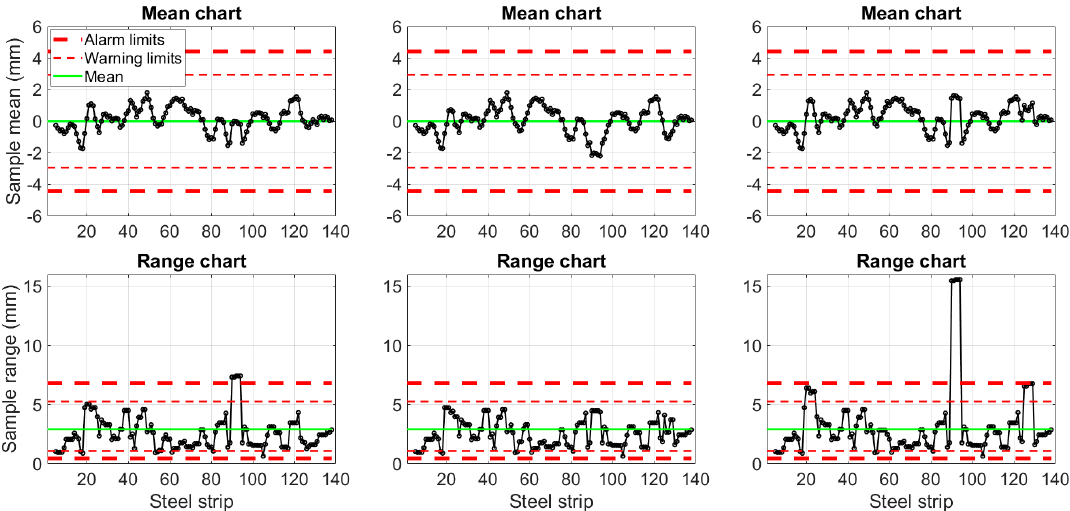
Figure 16. Control charts for the strip thickness in cases with drift upwards in the first explanatory variable ( left ), drift downwards in the first explanatory variable ( middle ), and drift upwards in all ten explanatory variables ( right ).